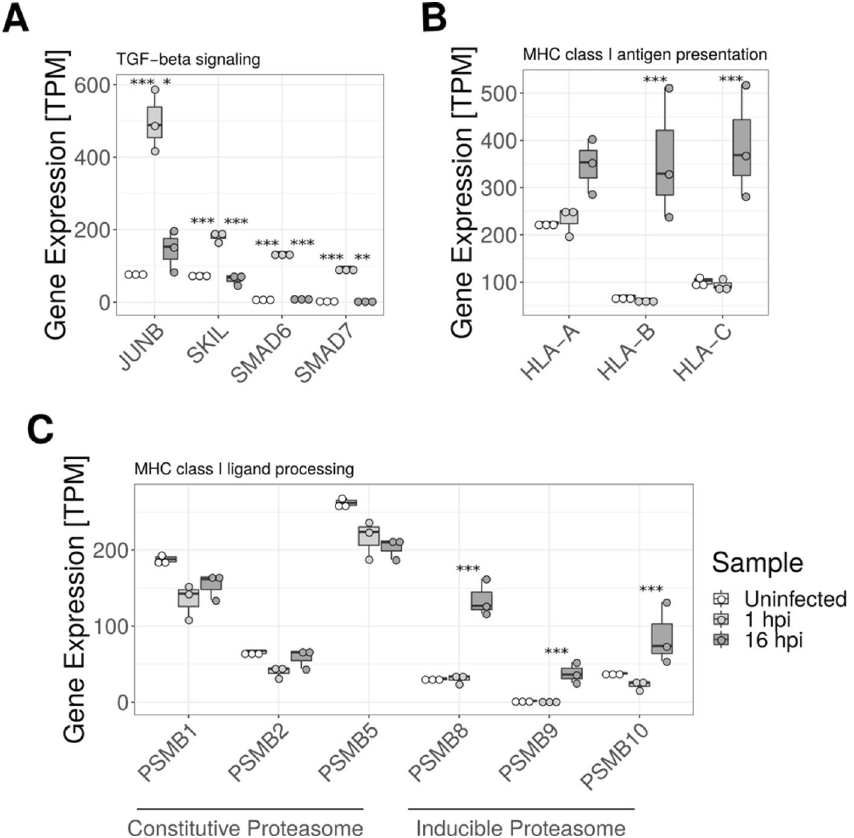
Figure 6. Examples of differentially expressed genes associated with enriched pathways. ( A ) Genes related to TGF-beta signaling ( JUNB , SKIL , SMAD6 , SMAD7 ). ( B ) Human leukocyte antigen ( HLA ) A/B/C . ( C ) Constitutive and inducible proteasomal subunits involved in processing of HLA associated peptides. * p < 0.05, ** p < 0.01, *** p <